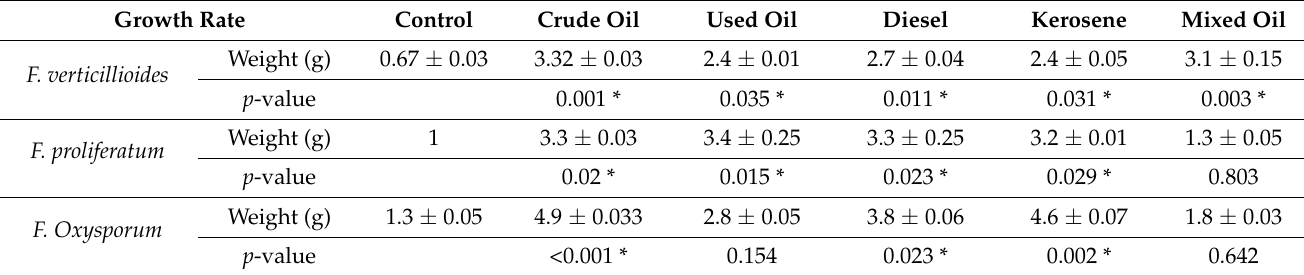
Table 3. Biomass production of filamentous fungi with different carbon